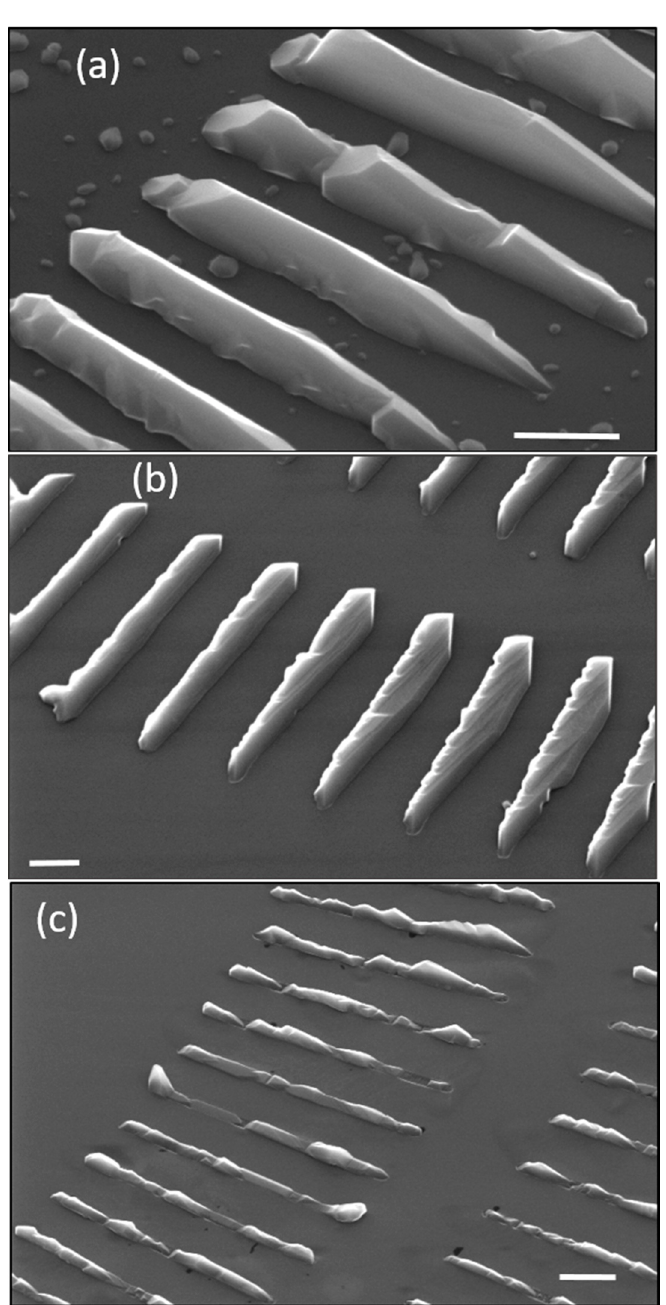
Figure 5. SEM images of not-perfect SAE of GaAs nanomembranes on (111) Ge substrates. ( a ) parasitic growth formation at a growth temperature of 580 °C; ( b ) 3D multiple sub-crystal GaAs nanomembranes formed at high As flux; ( c ) Formation of several nuclei in slits longer than 3µm, using the optimal SAE growth conditions (growth rate of 0.3 ML/s, As pressure equal to 2.5 × 10 − 6 torr and a substrate temperature of 600 °C),The scale bar for all SEM images is 1 μ m.